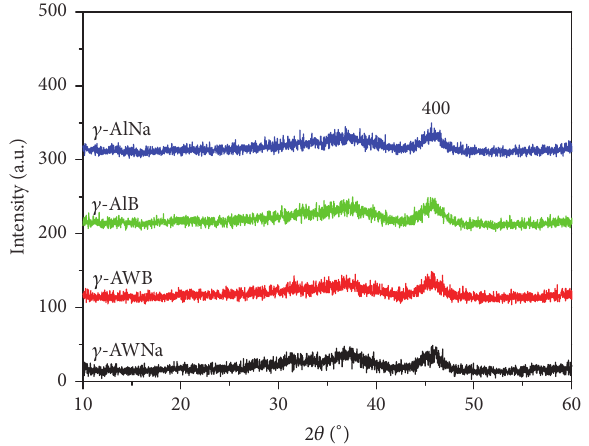
Figure 6: XRD patterns of 𝛼 -Al 2 O 3 obtained from AlCl 3 ⋅ 6H 2 O (AlNa, with NaOH, and AlB, with n-butylamine) and aluminum waste (AWNa, with NaOH, and AWB, with n-butylamine). Table 5: Specific area (BET) of boehmites and 𝛾 -aluminas.